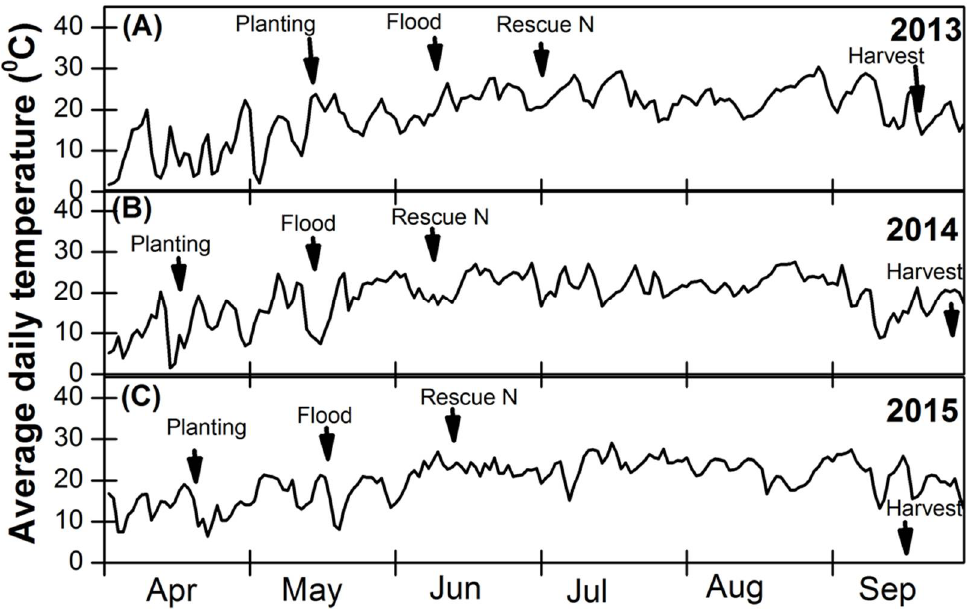
Figure 2. Average daily air temperature during the 2013 ( A ), 2014 ( B ) and 2015 ( C ) growing seasons at the Greenley Research Center near Novelty, Missouri. Timings of major field events are indicated by arrows.